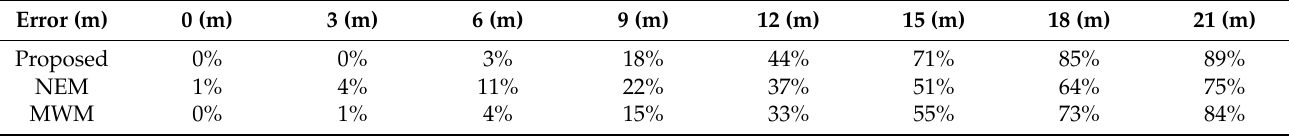
Table 15. KNN with Measurement Test Samples.